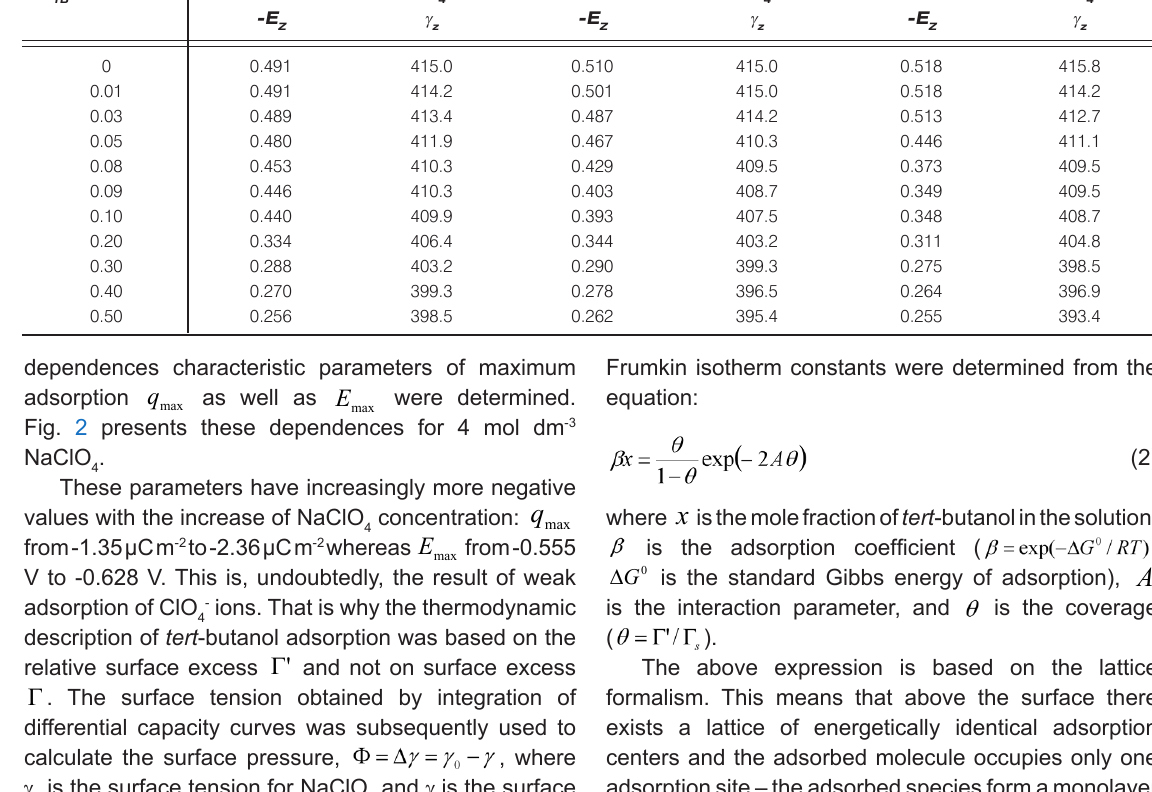
Table 1. The values of the zero charge potentials E C / mol dm TB